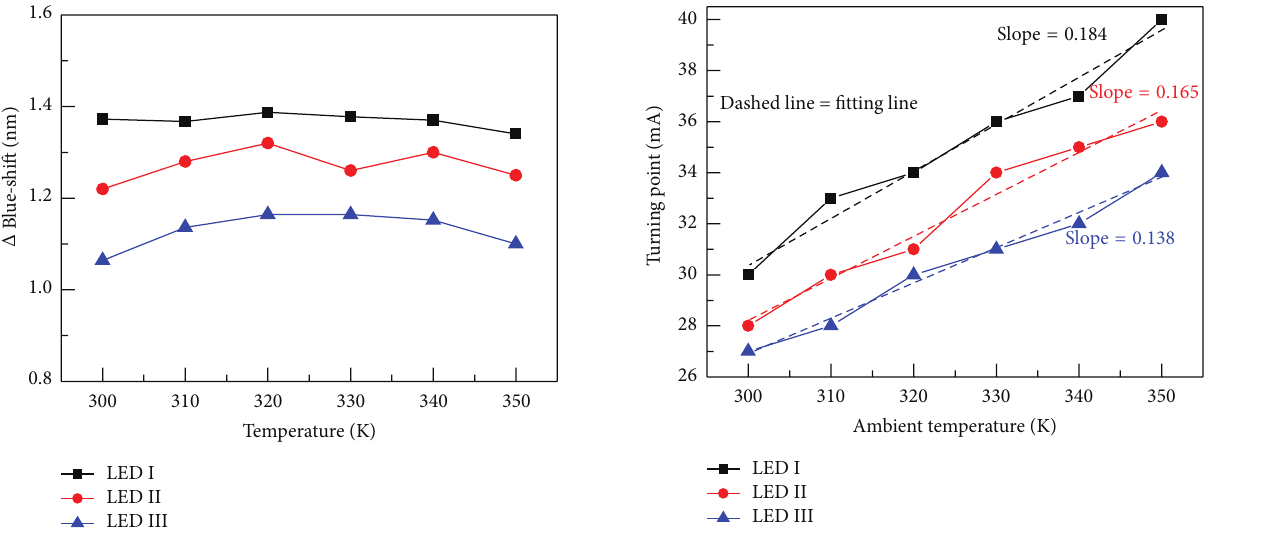
Figure 5: Blue-shift values of emission wavelength as functions of ambient temperatures for the three fabricated LEDs.